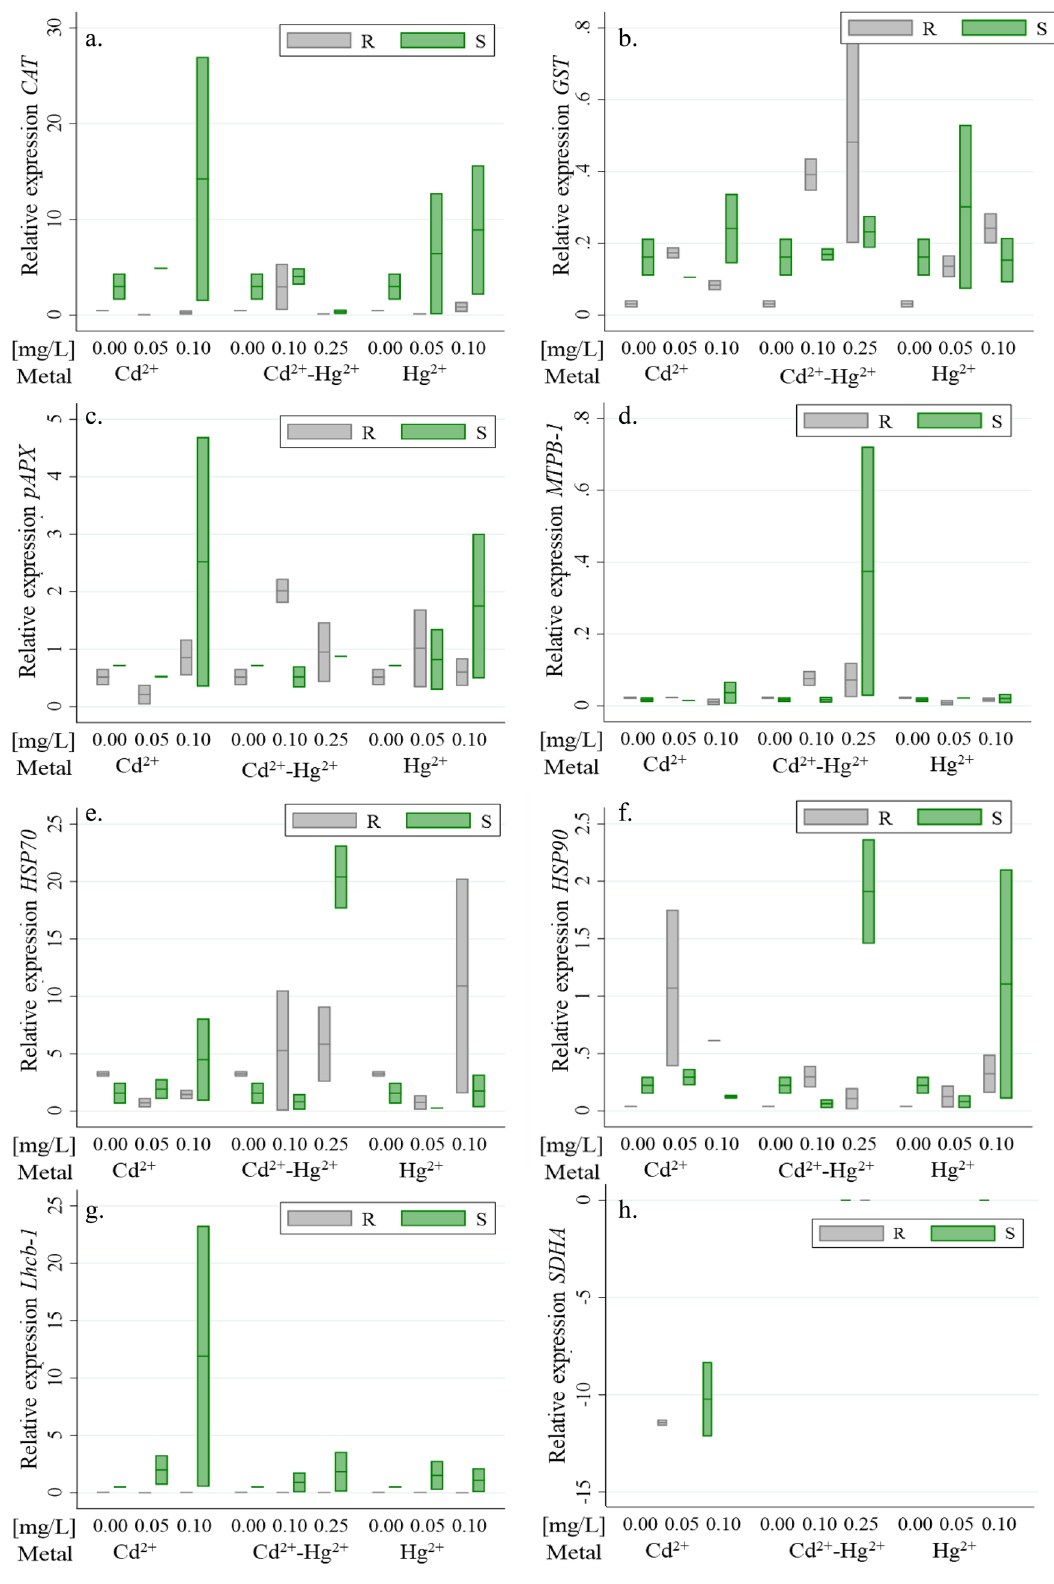
Figure 5. mean of gen relative expression in roots and stems expose for the different treatments ( a ) CAT , ( b ) GST , ( c ) pAPX , ( d ) MTPB-1 , ( e ) HSP70 , ( f ) HSP90 , ( g ) SDHA , ( h ) Lhcb-1. (R: root and S: